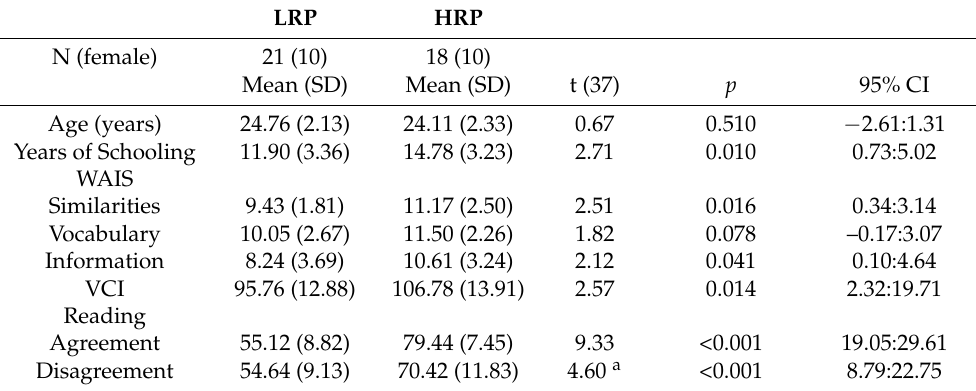
Table 1. Demographic data and WAIS subscale scores. Means and standard deviations. LRP